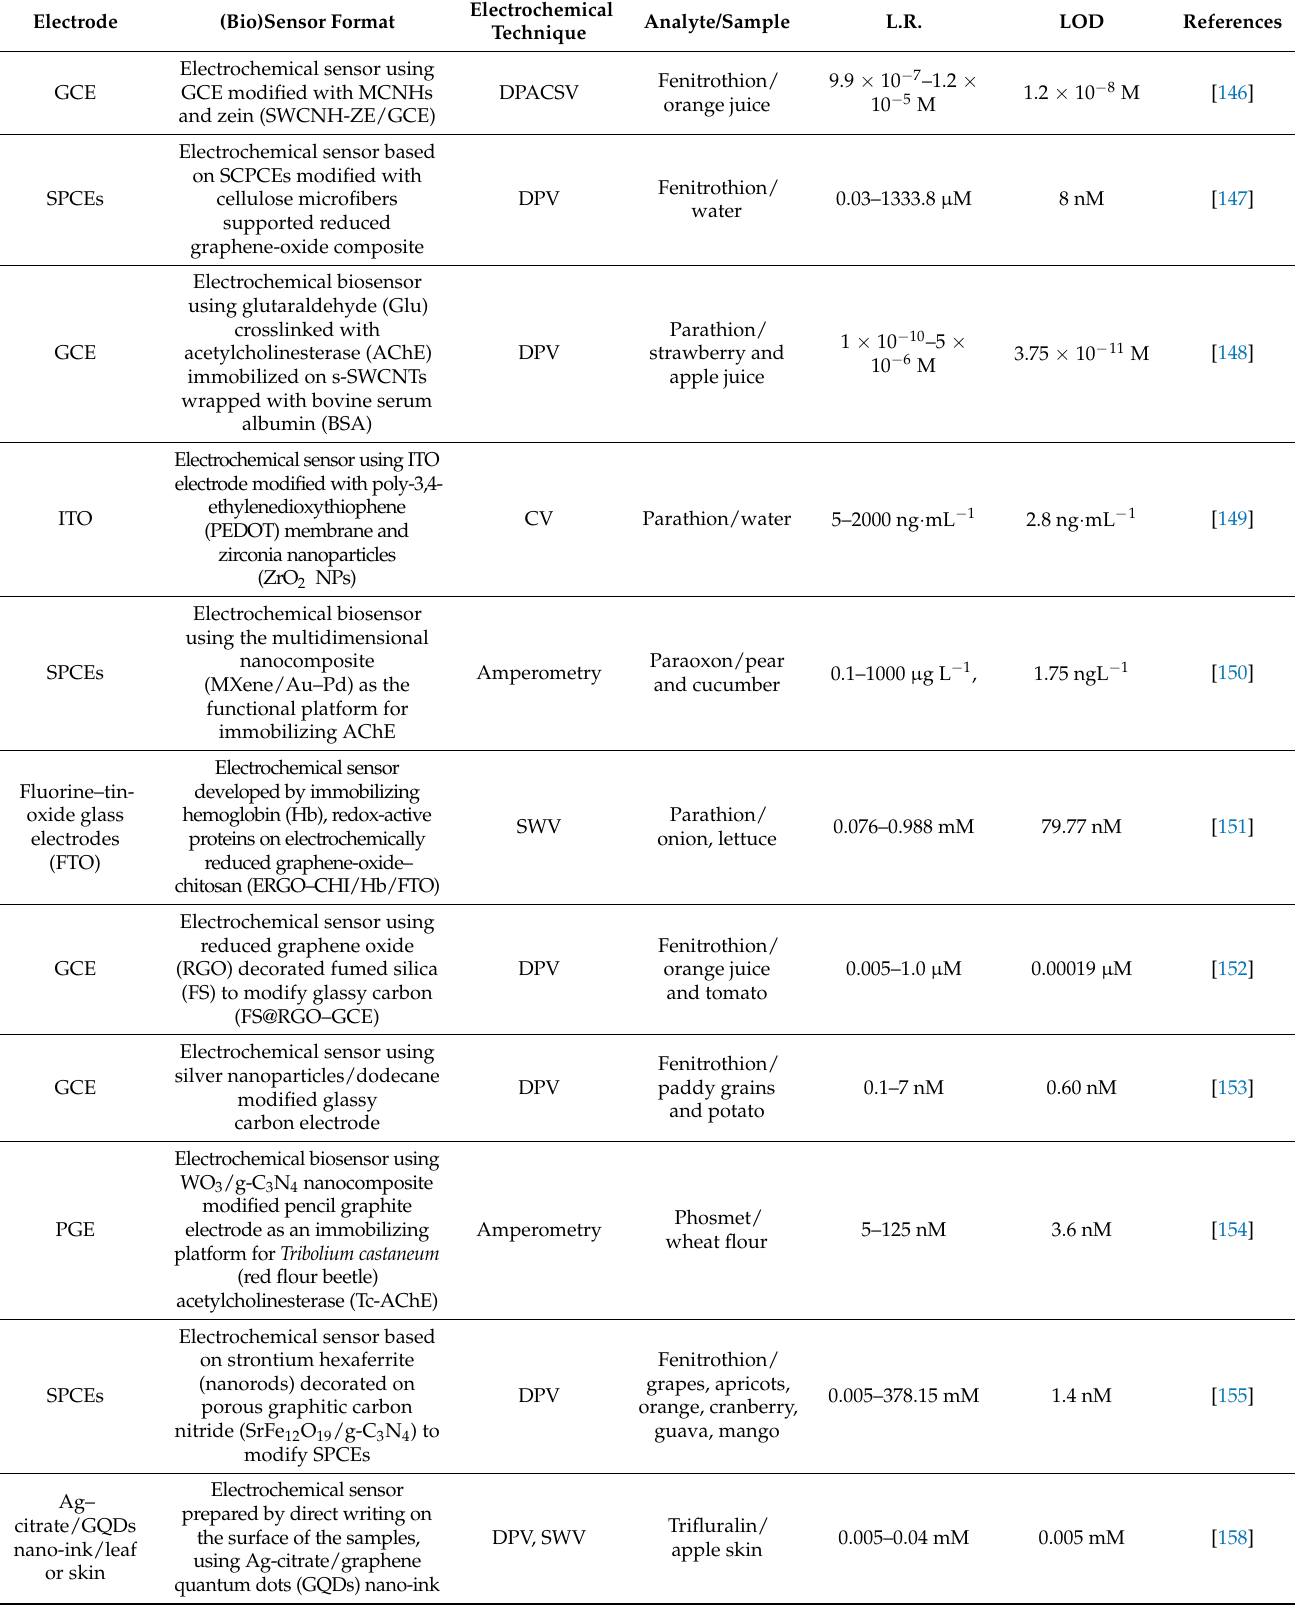
Table 3. An overview of recent electrochemical biosensors for pesticide